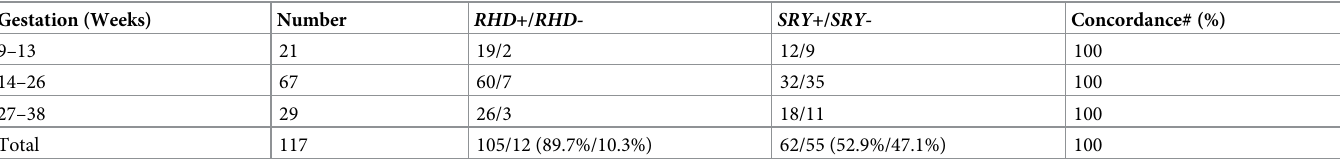
Table 3. Correlation between RHD and SRY genotyping at different gestational